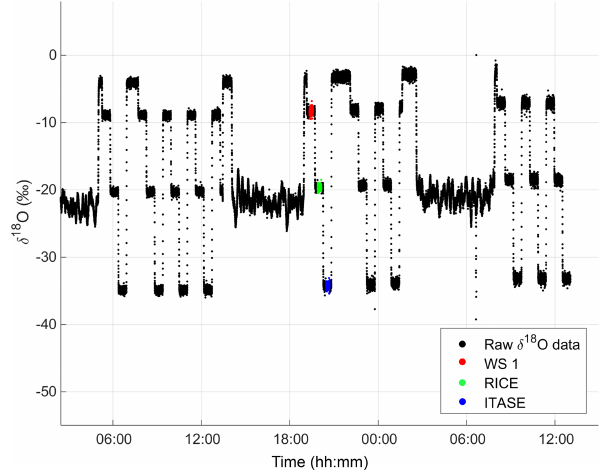
Figure 3. Time vs. raw δ 18 O (uncalibrated) for 1 day of melting (3 July 2014). Values of standards drift noticeably over the course of the day. An example of one calibration cycle of three water stan- dards run between ice core stacks is marked in colour: WS1 (red), RICE (green) and ITASE